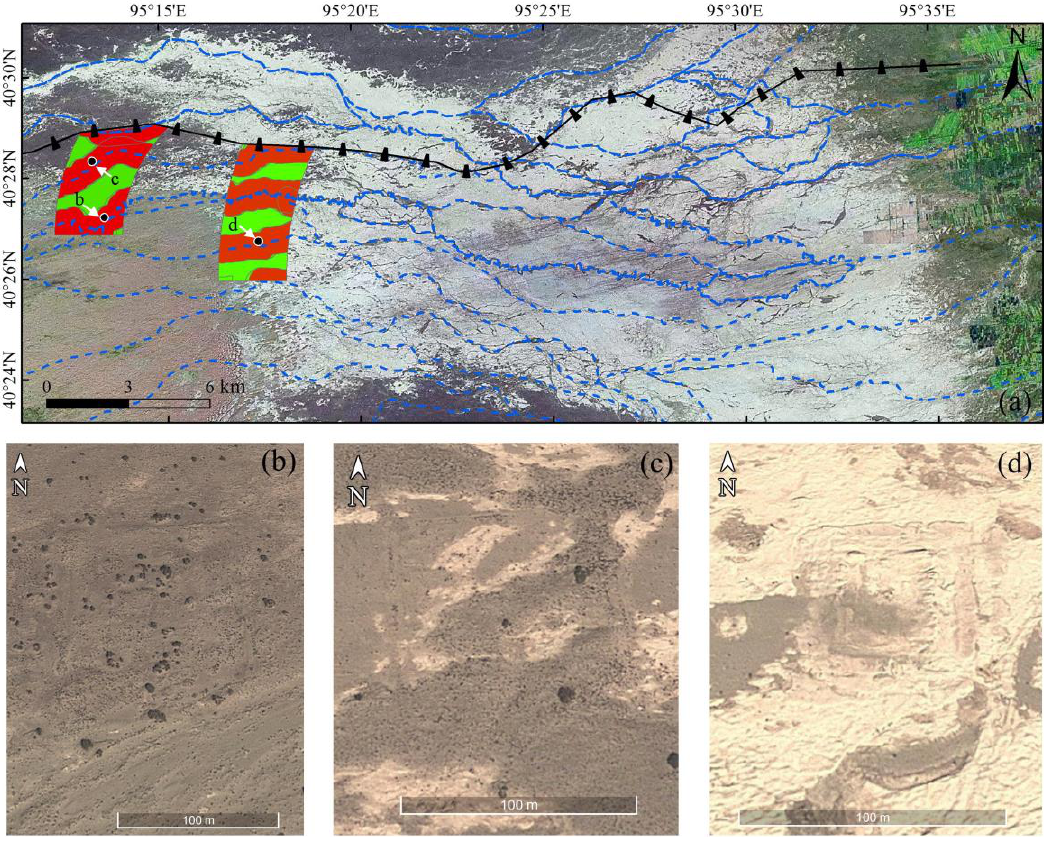
Figure 7. Medieval post stations in Dunhuang. ( a ) Prospective sub-areas to medieval post stations based on Landsat image interpretations and GIS analysis, red and green areas represent the high and low archaeological potential, respectively, blue dotted lines indicate dried and buried channels, and the black line indicates the Great Wall of Han Dynasty; ( b – d ) GE VHR images from September 2013 (© 2018 Digital Globe) of post station sites.